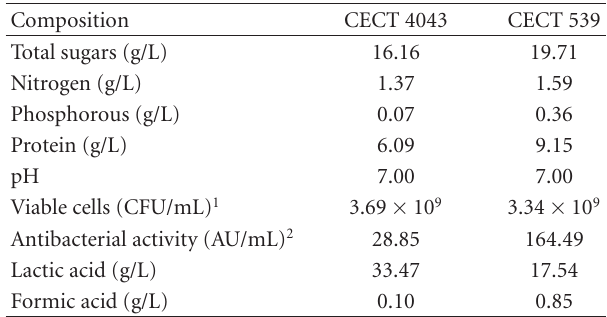
Table 1: Mean composition of the probiotic preparations obtained from realkalized fed-batch cultures of Lact. casei CECT 4043 and L. lactis CECT